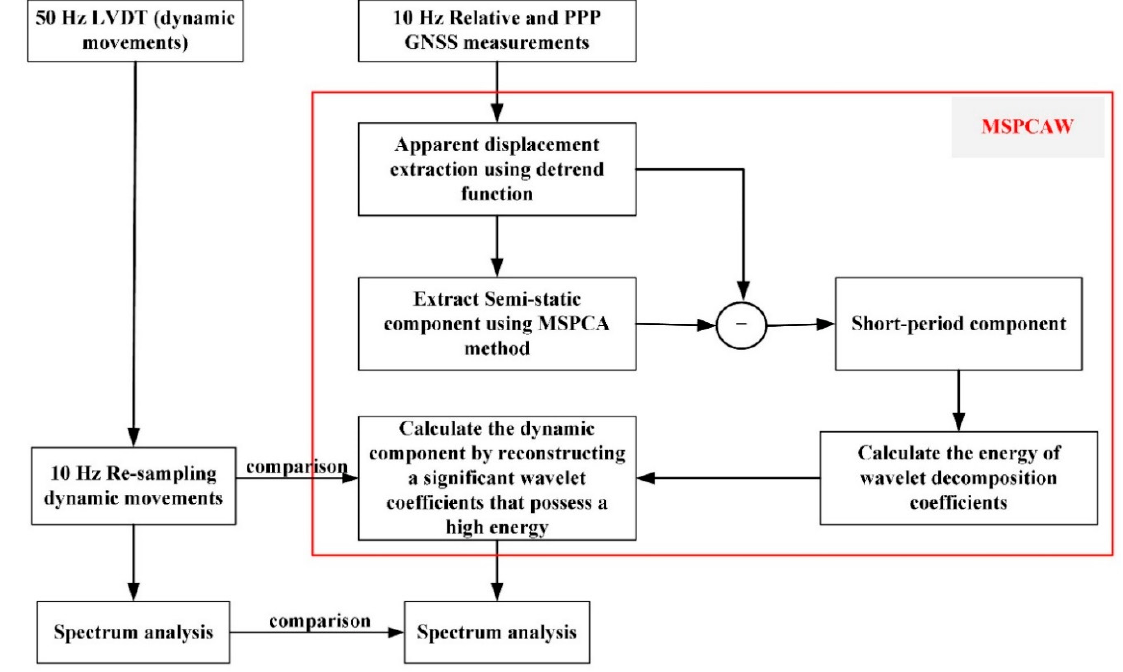
Figure 2. Multiscale principal component analysis and wavelet transform (MSPCAW) model diagram and study process.